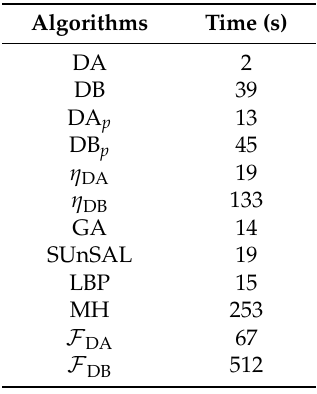
Table 6. Processing time (in seconds) for Indian Pines dataset with 695 training samples and 9671 test